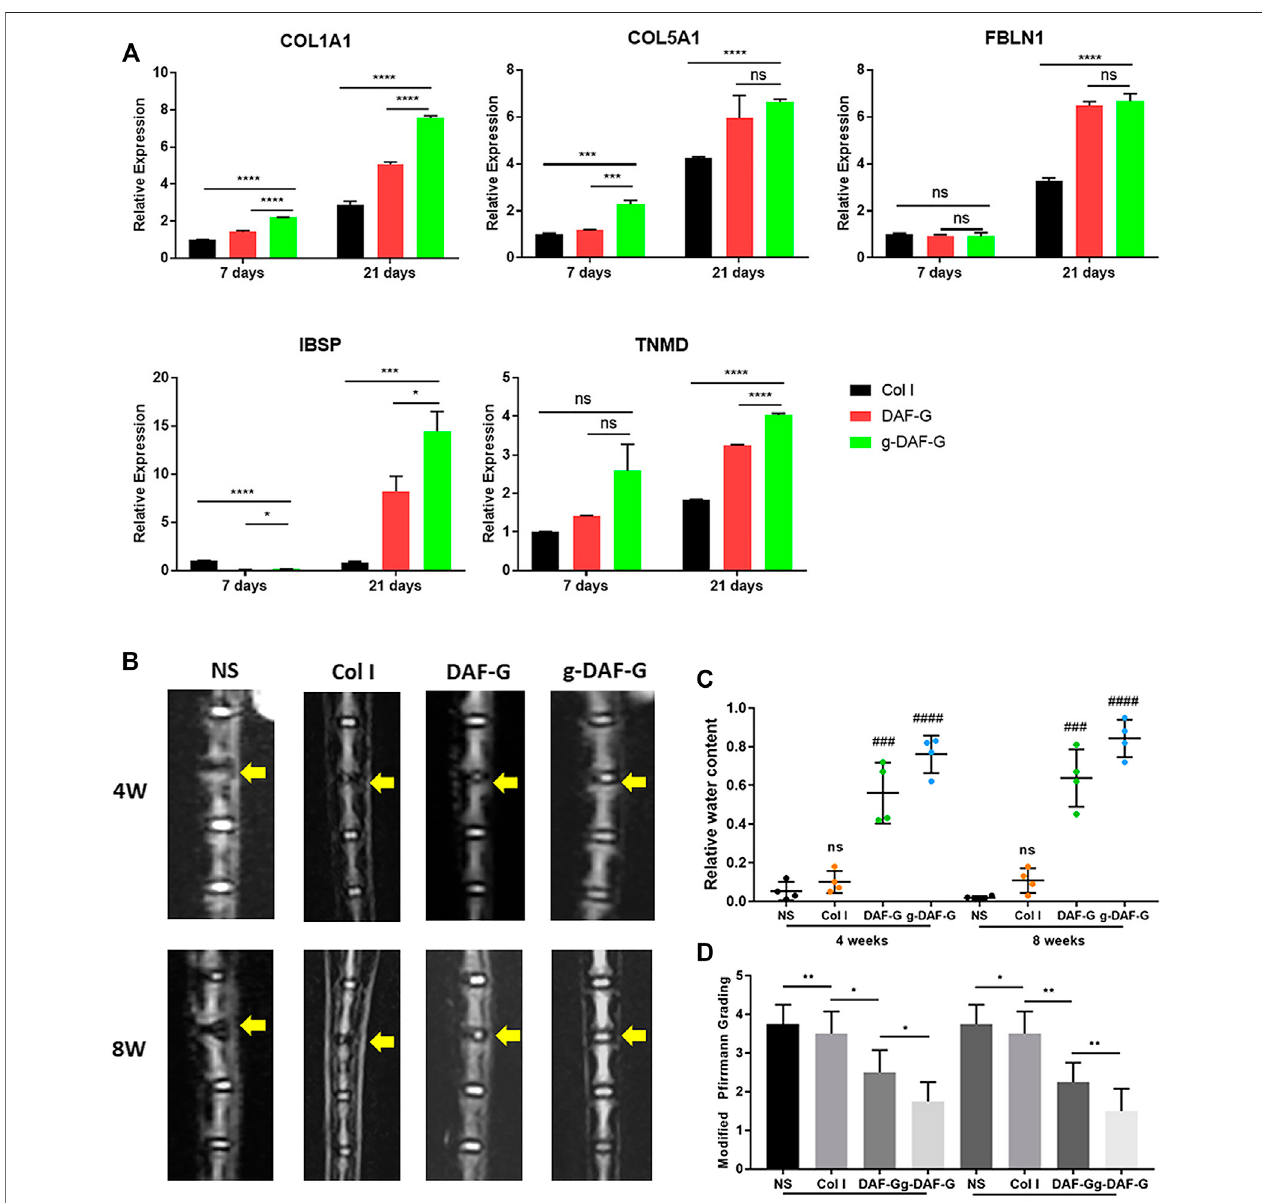
FIGURE 3 | (A) The level of expression of AF-speci fi c genes (collagen-1A1(COL1A1), collagen-5A1(COL5A1), fi bulin-1 (FBLN1), integrin-binding sialoprotein (IBSP), and tenomodulin (TNMD)) was signi fi cantly higher in the DAF-G and g-DAF-G groups than Col I group on Day 21, which indicated the potential induction of directing speci fi c differentiation of hBMSCs towards AF cells on DAF-G and g-DAF-G hydrogels. (B) The T2-weighted images showed that intervertebral space became narrower and the signal intensity of the NP region sharply declined in normal saline (NS) group as compared with the adjacent and intact disks. (C) Quantitative analysisshowedthatrelativewatercontentofDAF-Gandg-DAF-GgroupswerelargerthantheColIgelandtheNSgroups,indicatingapotentialregenerativefunctionof AF-derivedhydrogelsonAFtissuedefect. (C,D) Therestorativeeffectanalyzedbyquantitativeanalysisandmodi fi edP fi rrmanngradingwasbettering-DAF-GthanDAF- G group, revealing that the mechanical strength improved by genipin might be a vital factor in AF repair. ( (A – D) Adapted from Peng et al. (2020a)).